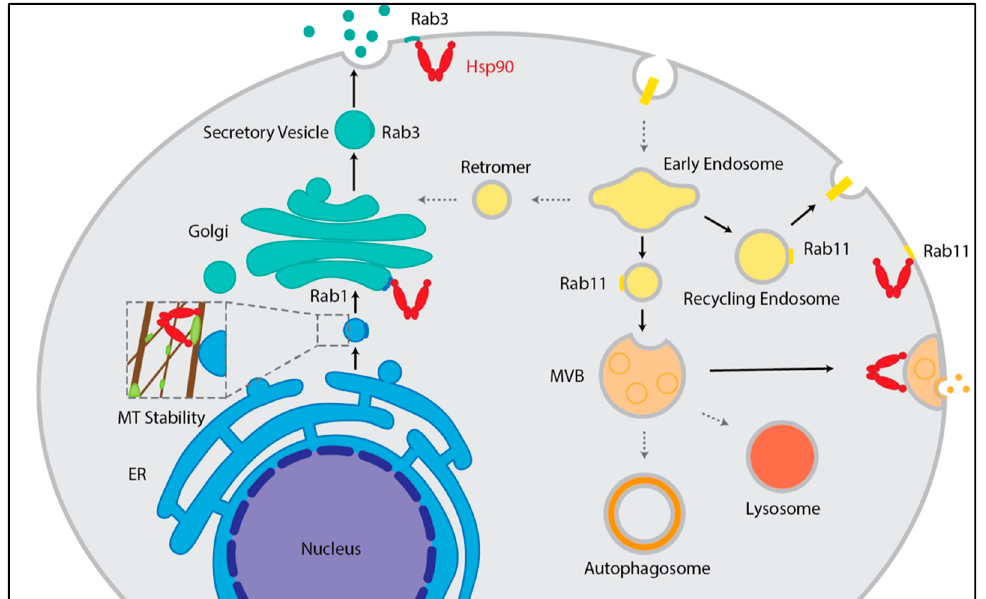
Figure 2. Hsp90 contributions to exocytic and endocytic trafficking. In the exocytic pathway (left), Hsp90 (red) aides in anterograde vesicle trafficking between the ER and Golgi by supporting microtubule stability through the binding of MAP4 (light green) [28–32], and the recycling of Rab1 and Rab3 to enable vesicle targeting and fusion with the Golgi and plasma membrane [28,29,33–35]. In the endocytic pathway (right), Hsp90 supports the transport of recycling endosomes as well as transport from early to late endosomes/multivesicular bodies (MVB) through the recycling of Rab11 [15,36,37]. Hsp90 also allows for the fusion of MVB with the plasma membrane by aiding in membrane deformations [38]. Transport events that Hsp90 is involved in are noted by solid black arrows.